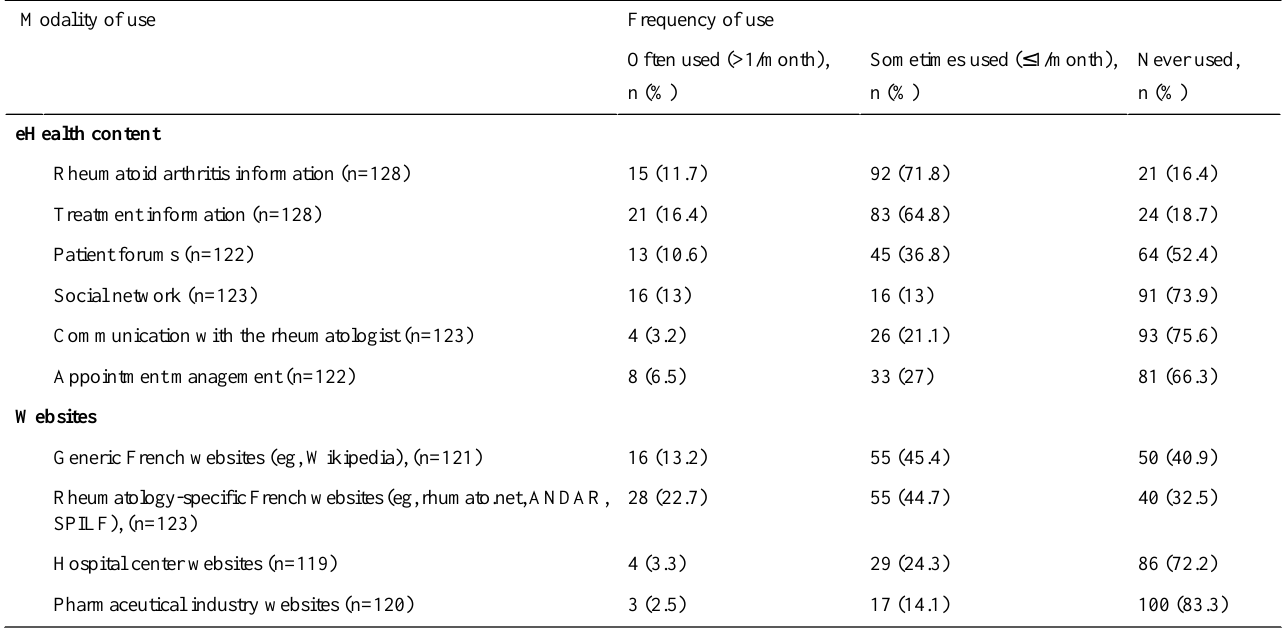
Frequency of use Modality of use (%)Often used (>1/month), n (%)